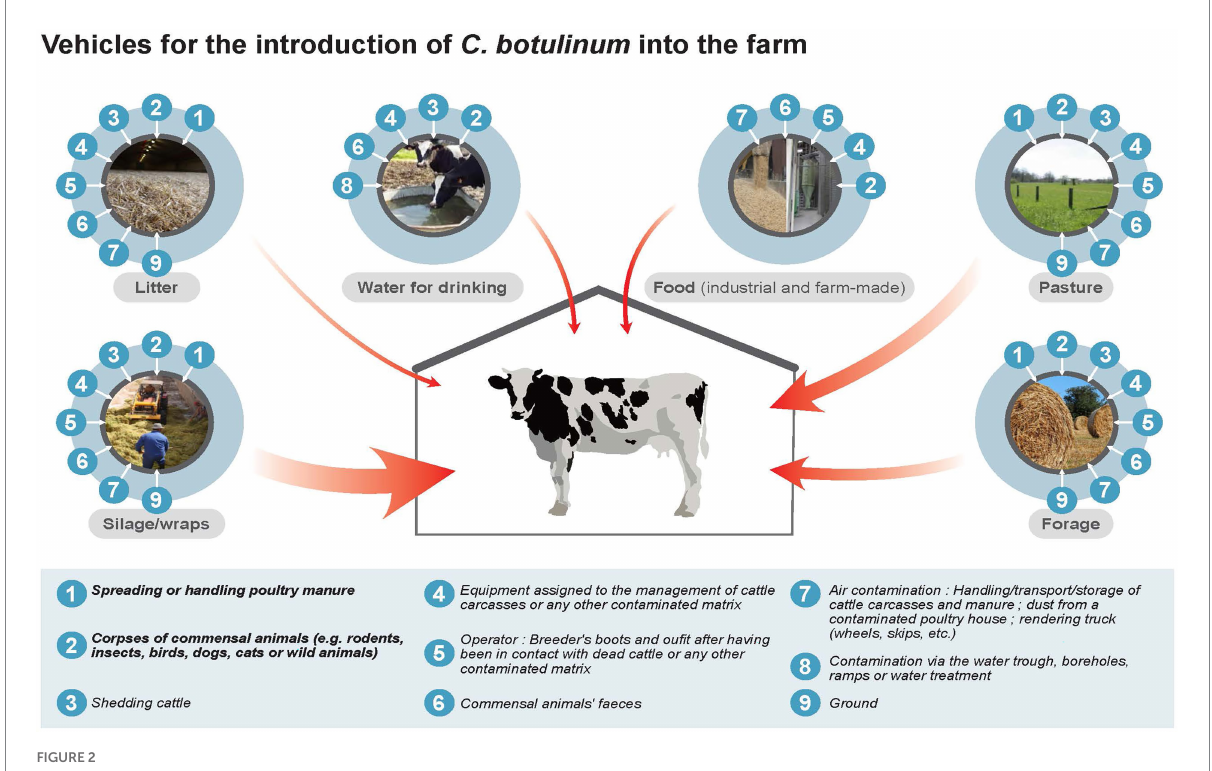
FIGURE 2 Epidemiological cycle of Clostridium botulinum in cattle